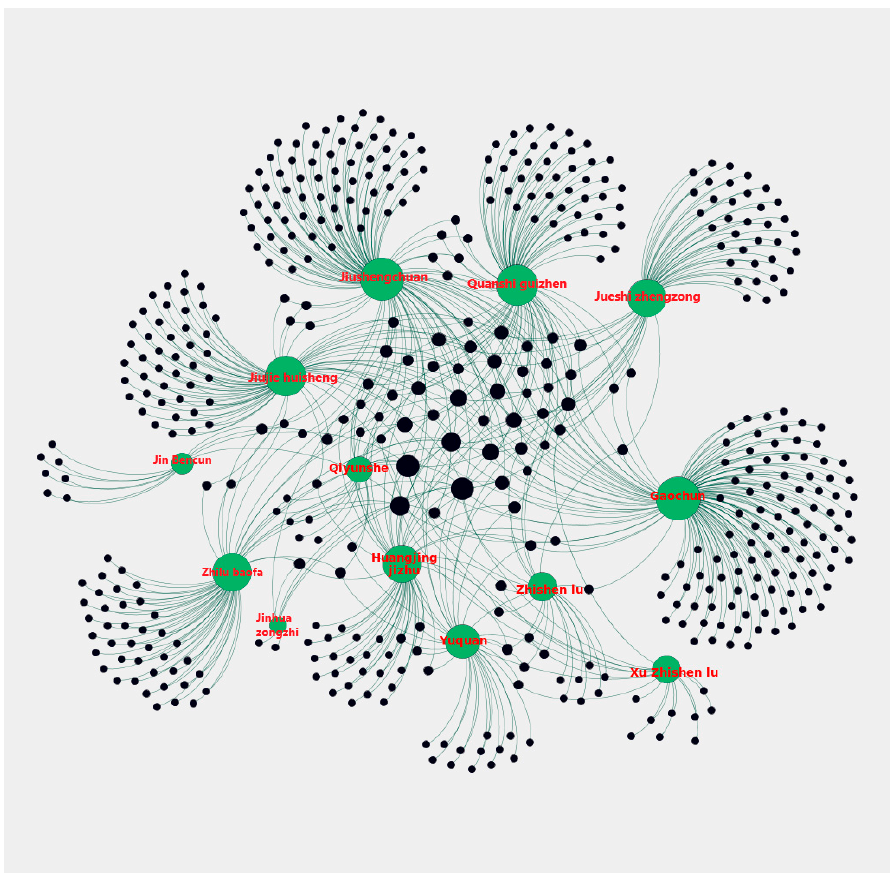
Figure 1. General overview. Altar-nodes in green, god-nodes in black, all node sizes proportional to connectivity.